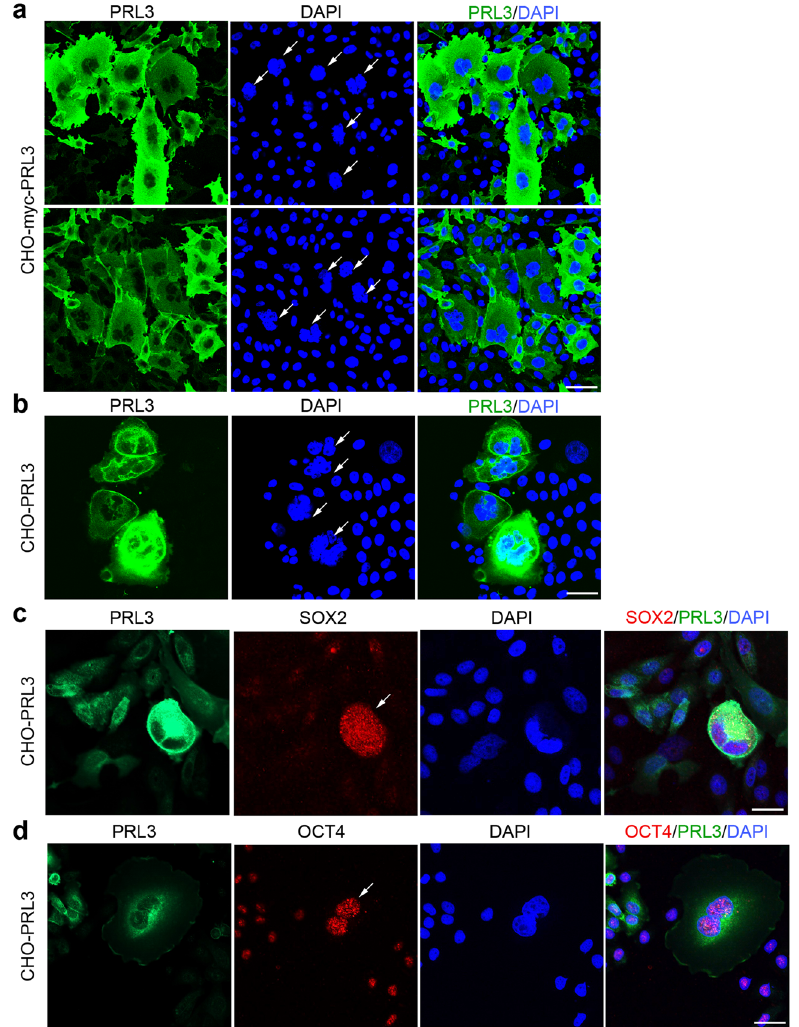
Fig. 1 PRL3 overexpression induces the formation of stem cell-like polyploid giant cells. a , b Immuno fl uorescence analysis of CHO cell lines stably expressing ( a ) myc-tagged PRL3 or ( b ) GFP-tagged PRL3 (CHO-PRL3). White arrows indicate multinucleated cells overlapped with high PRL3 expression. Cells in a were visualized via indirect staining with anti-PRL3 antibody (clone 318). Bar, 50 µ m. c , d Immuno fl uorescence analysis of CHO-PRL3 cell pools with antibodies against ( c ) SOX2 and ( d ) OCT4. White arrows indicate multinucleated giant cells with elevated expression of both embryonic stem cell markers compared to mononucleated cells. Bar, 50 µ